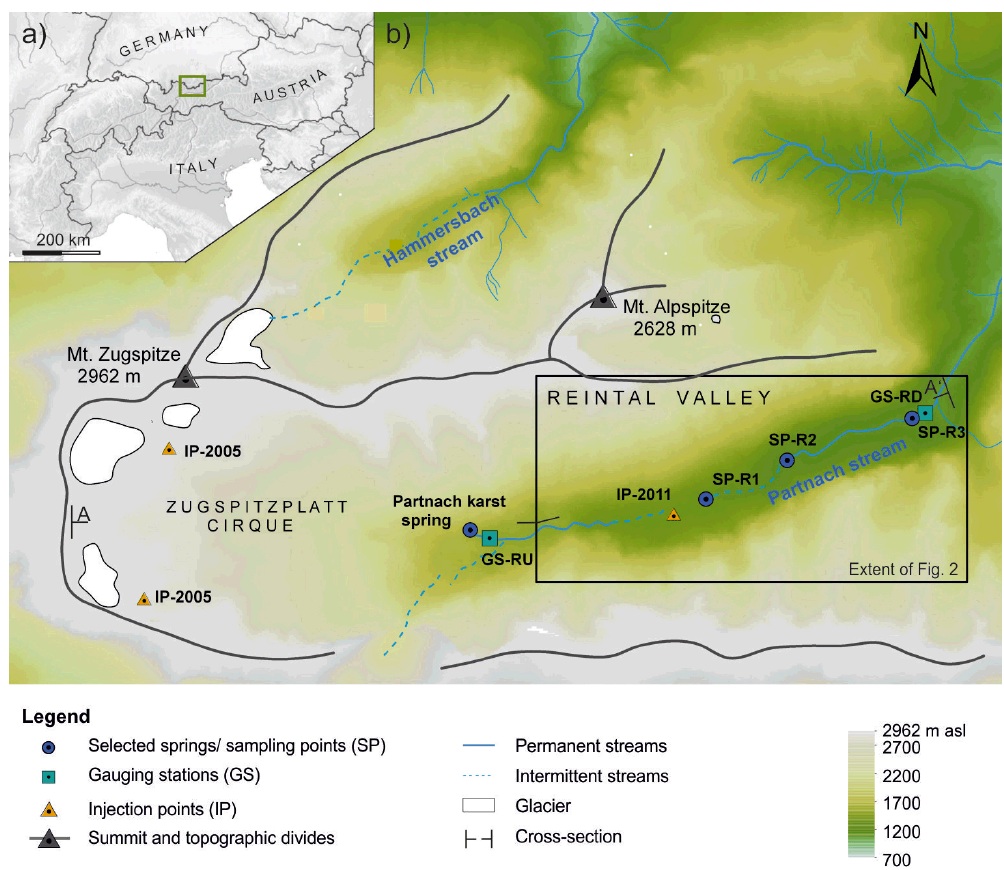
Figure 1. (a) Map of the study site (Wetterstein mountains) in the German Alps; (b) Wetterstein mountains, including Germany’s highest summit (the Zugspitze), the large Zugspitzplatt cirque, and the high alpine Reintal extending to the east. Tracer injections at the Zugspitzplatt cirque (IP-2005) were conducted by Rappl et al. (2010); IP-2011 is part of this study. GS-RU and GS-RD are gauging stations in the Reintal, upstream (RU) and downstream (RD) from the alluvial/rockfall aquifers. The area in the rectangle is shown in detail in Fig. 2. A detail of the cross-section A–A’ is provided in Fig.